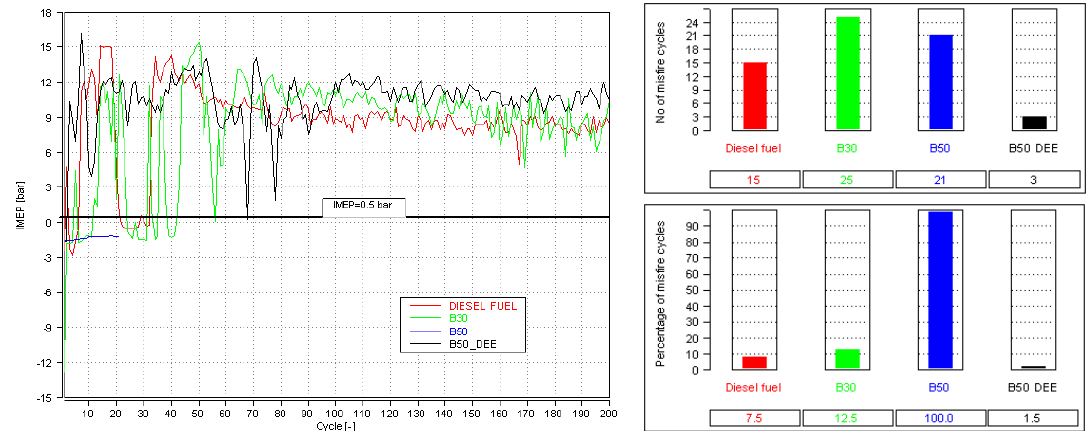
Figure 9. Misfire engine cycles.